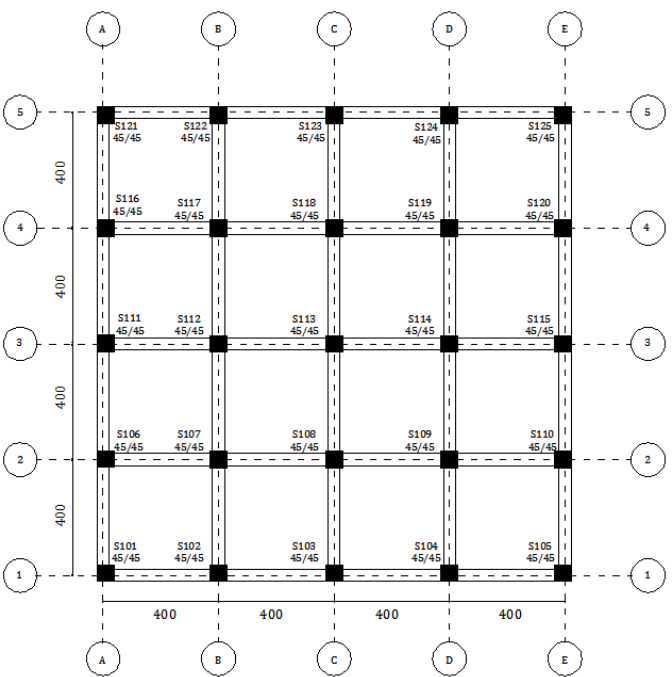
Figure 4. The blueprint of the sample RC building (all dimensions are in cm).